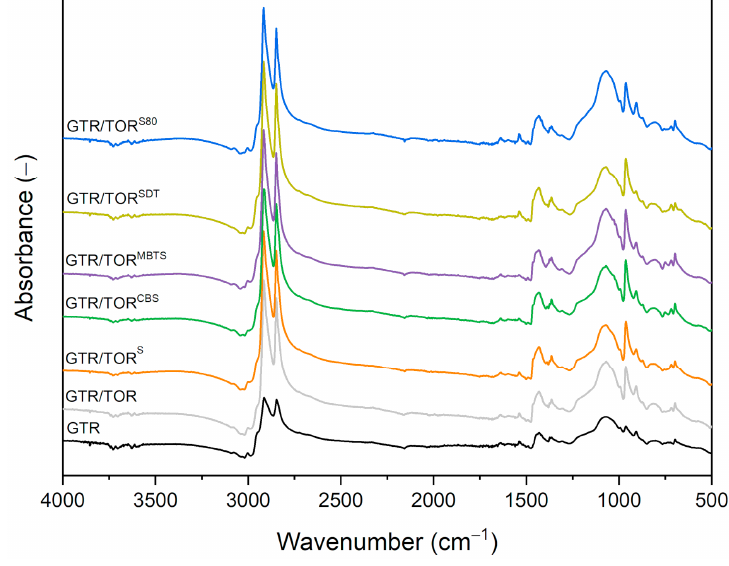
Figure 3. FTIR spectra of the studied compounds.